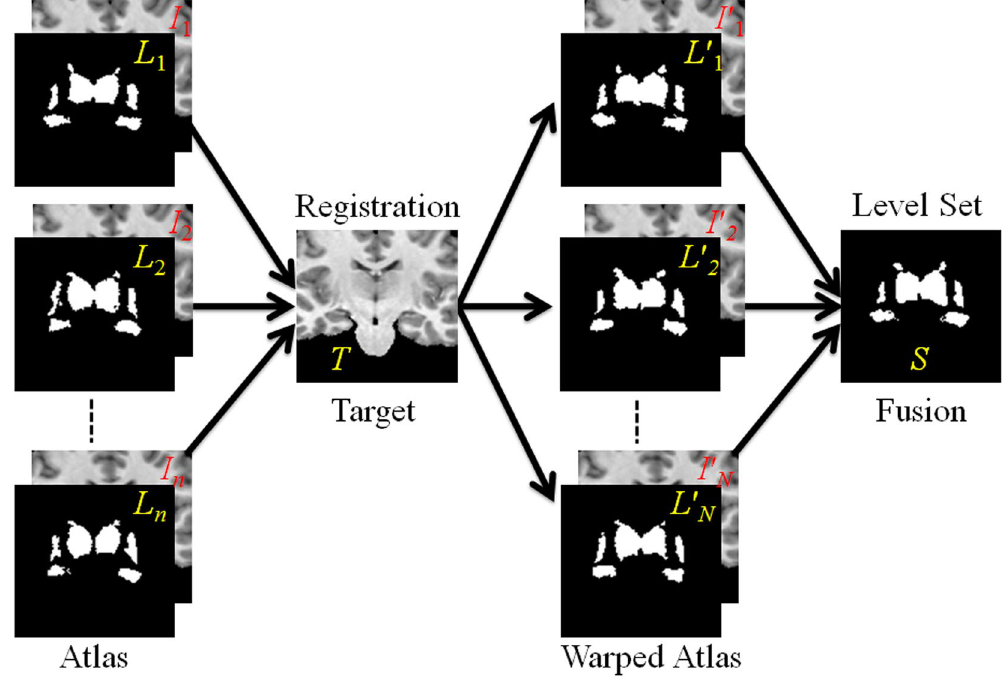
Figure 2. Schematic illustration of our segmentation